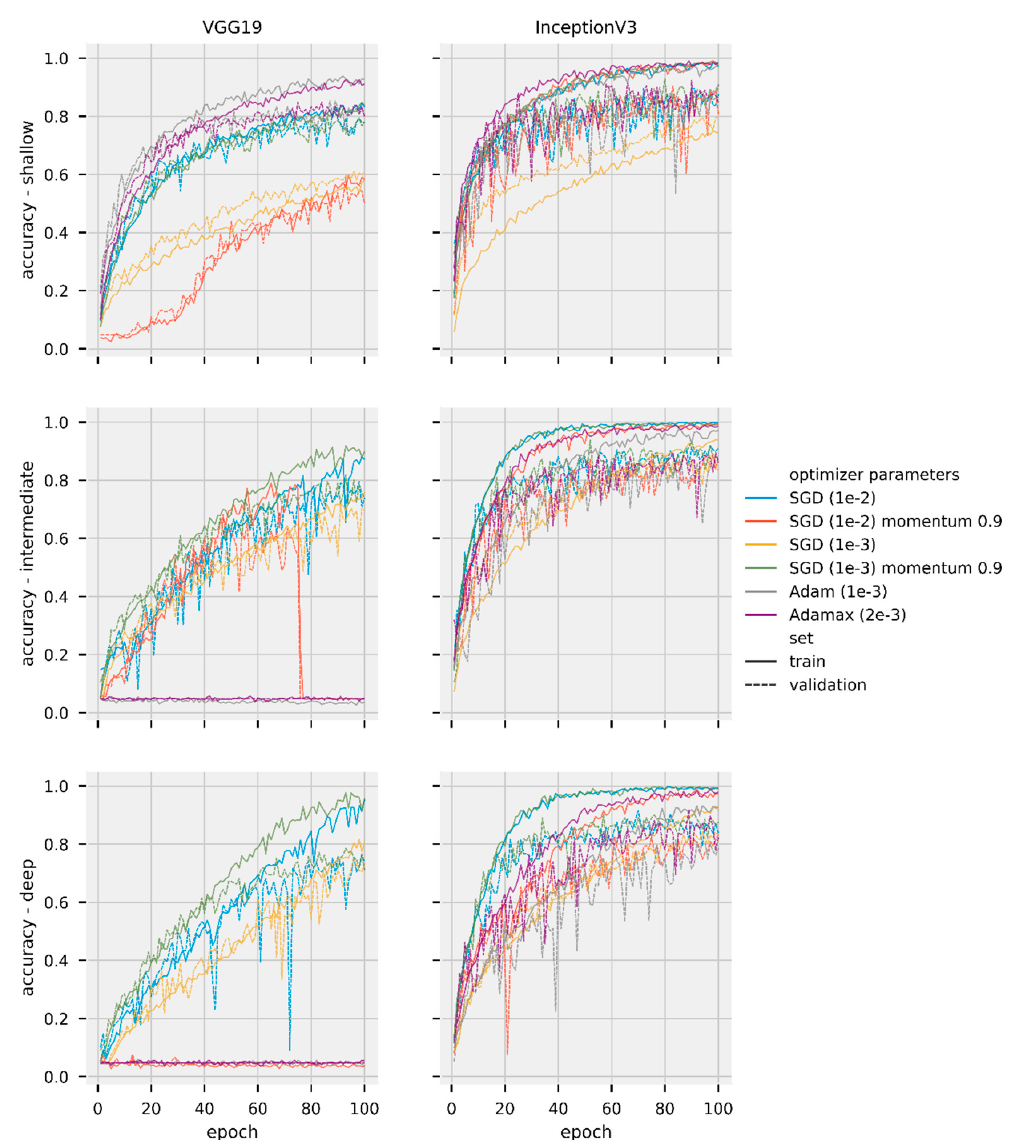
Figure 3. Accuracy per epoch for training and validation sets for different models and optimizers trained on the UCMerced dataset. The left column shows results for VGG19 models. The right column shows results for Inception V3 models. The first row shows shallow models, center shows intermediate, bottom shows deep models. Different colors represent different optimizers. Different and line style represent different datasets (solid for training, dashed for validation).